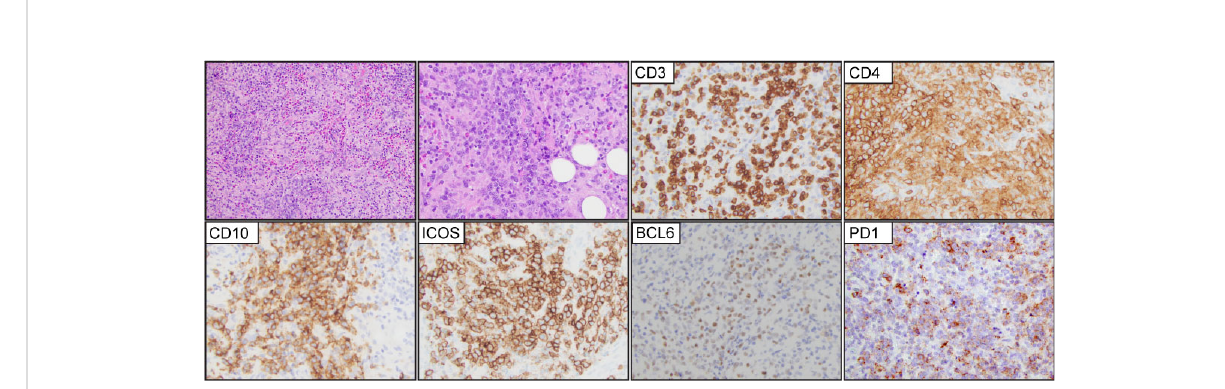
FIGURE 6 T-follicular helper type peripheral T-cell lymphoma (PTCL-TFH). Representative (H&E) images demonstrate effacement of the nodal architecture by medium to large, atypical lymphocytes that are organized in small clusters with numerous background histiocytes and eosinophils. The tumor cells are positive for CD3, CD4, CD10, ICOS, BCL6, and PD1.